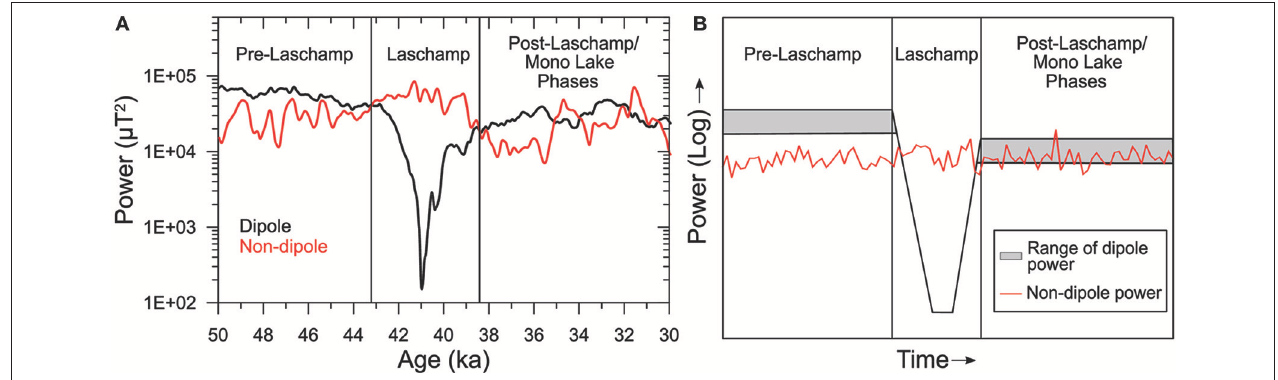
FIGURE 10 | Dipole and non-dipole power evolution at the CMB between 50 and 30 ka from LSMOD.2 (A) and a generalized schematic of three proposed geodynamo states (B) . The gray box encapsulates the range of slow dipole power variations. Faster non-dipole power is shown as white noise.